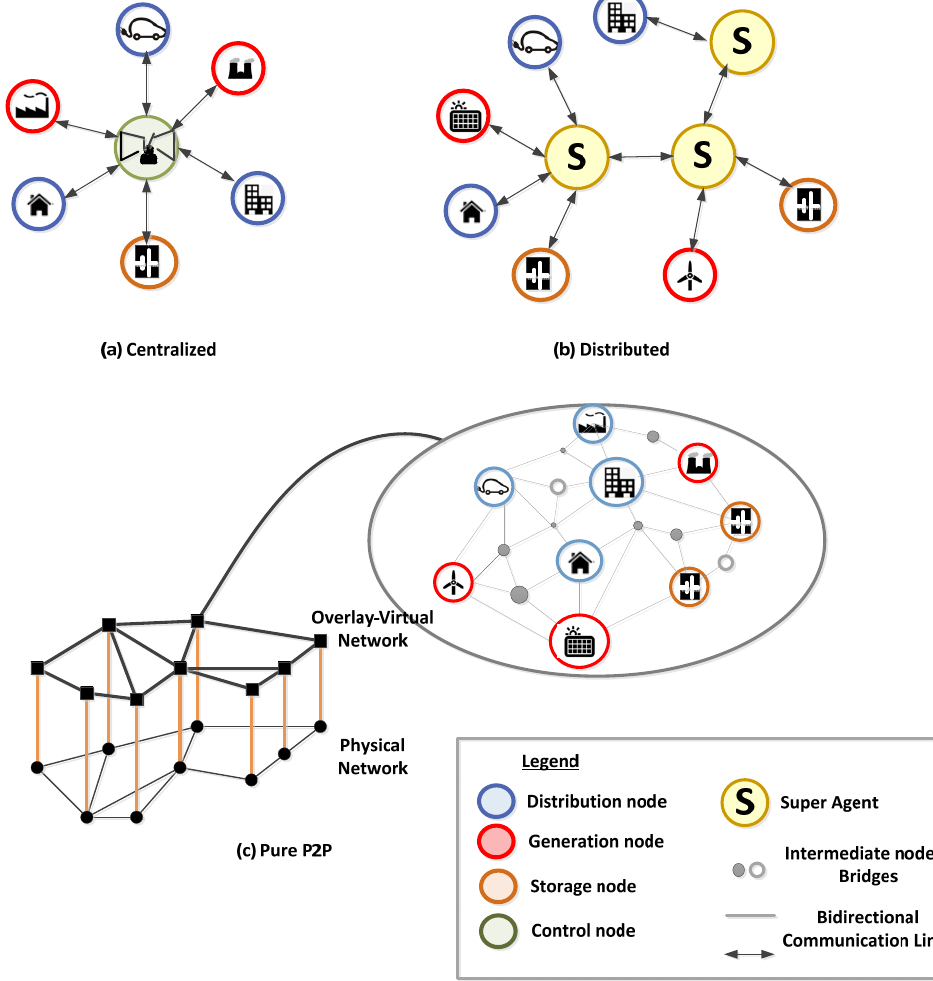
Figure 2. ( a ) Centralized; ( b ) Distributed and ( c ) Pure P2P Communication Architectures.